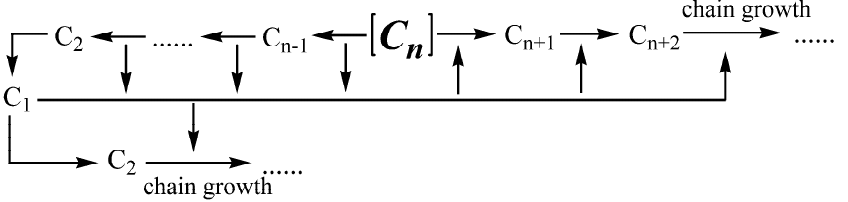
7 Figure 3. The detailed product distribution of heavier 1-alkene reaction (T = 533 K, p = 0.8 MPa). ( a ) C 6 H 12 in H 2 atmosphere, H 2 /C 6 H 12 = 2.1. ( b ) C 8 H 16 in H 2 atmosphere, H 2 /C 8 H 16 =